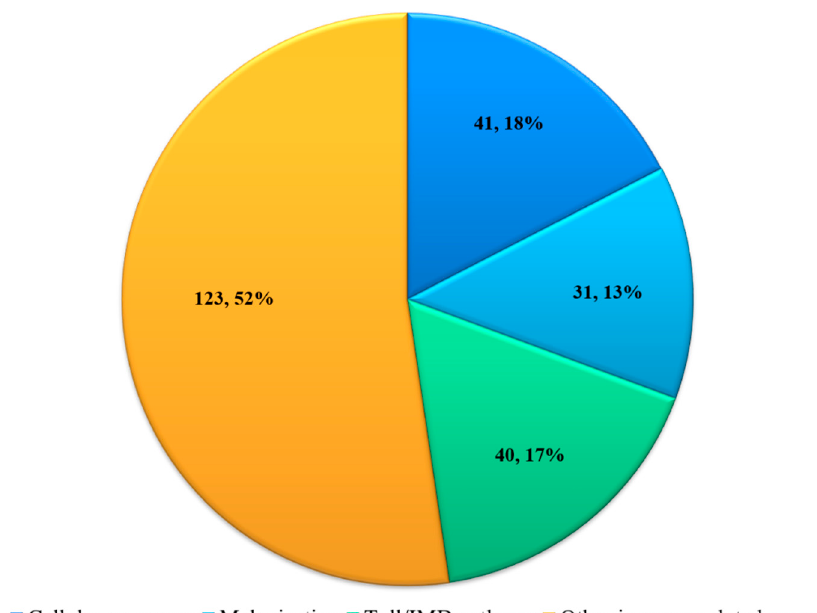
Figure 2. Number and percentage of differentially expressed immune-related genes in H. cunea infected by SM1 . The distribution number and percent of differentially expressed immune-related genes in each slice are shown on the pie. All genes shown in the Supplementary Material: Table S2.